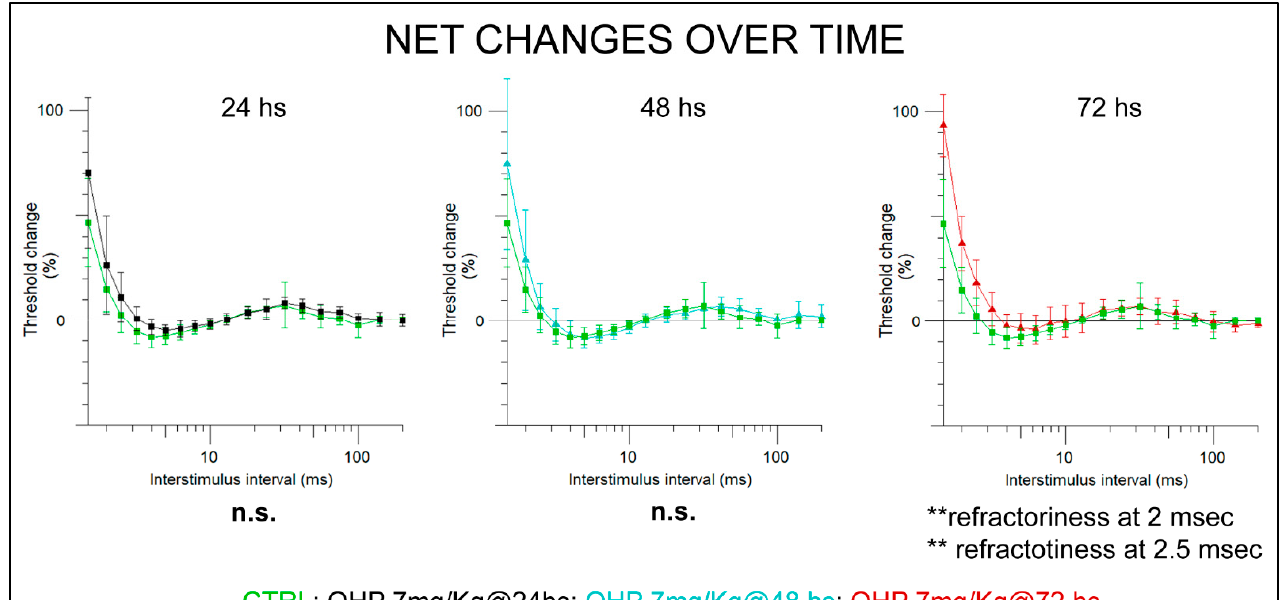
Figure 2. NET findings at recovery cycle at 24, 48, 72 h following 1st Oxaliplatin i.v., administration. Statistical significance of Mann–Whitney U-test is shown. In the graph, individual values are accompanied by SEM bars (** p -value < 0.01 vs. CTRL). CTRL: control group (green curves); OHP: OHP-treated group (curves at 24 h are shown in black, at 48 h in cyan, and at 72 h in